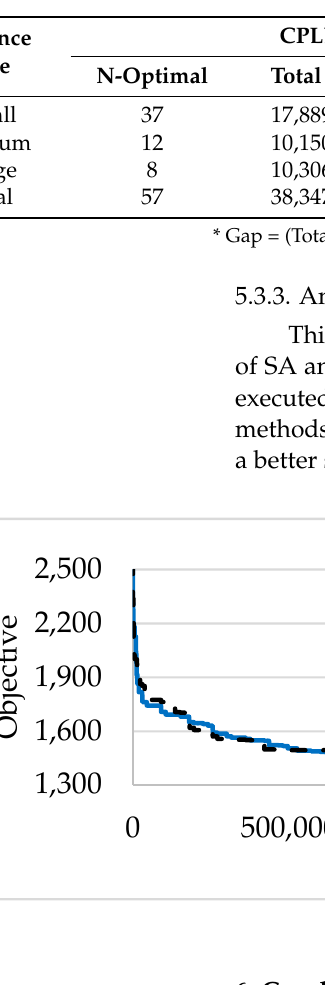
Table 11. Summary of the instances that obtain the optimal solution between CPLEX and SARS.